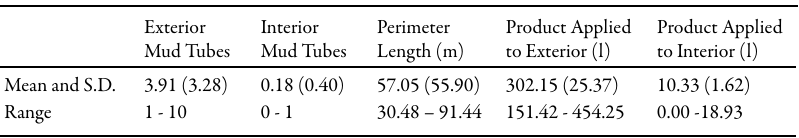
Table 2. Mean, Standard Deviation, and Range of exterior and interior mud tubes, perimeter length, and amount of chlorantraniliprole applied to the exterior and interior of structures associated with the field study during initial observations and